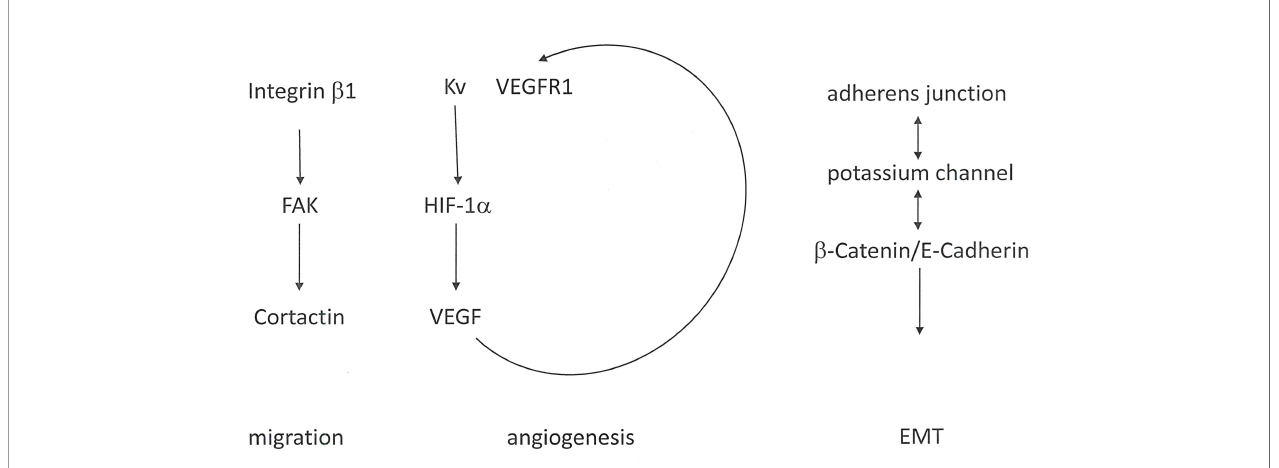
FIGURE 3 | K V channels in cancer metastasis. Alterations in potassium homeostasis contribute to cell migration, angiogenesis and EMT. In the cell membrane, the K V channel associates with Integrin b 1 and VEGFR (Vascular Endothelial Growth Factor